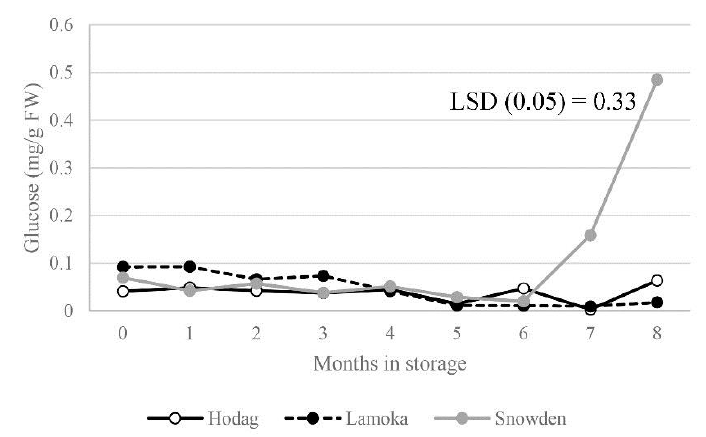
Figure 6. Glucose content (mg/g Fresh Weight) of Hodag ( a ), Snowden ( b ) under the three wound healing treatments in 2017.